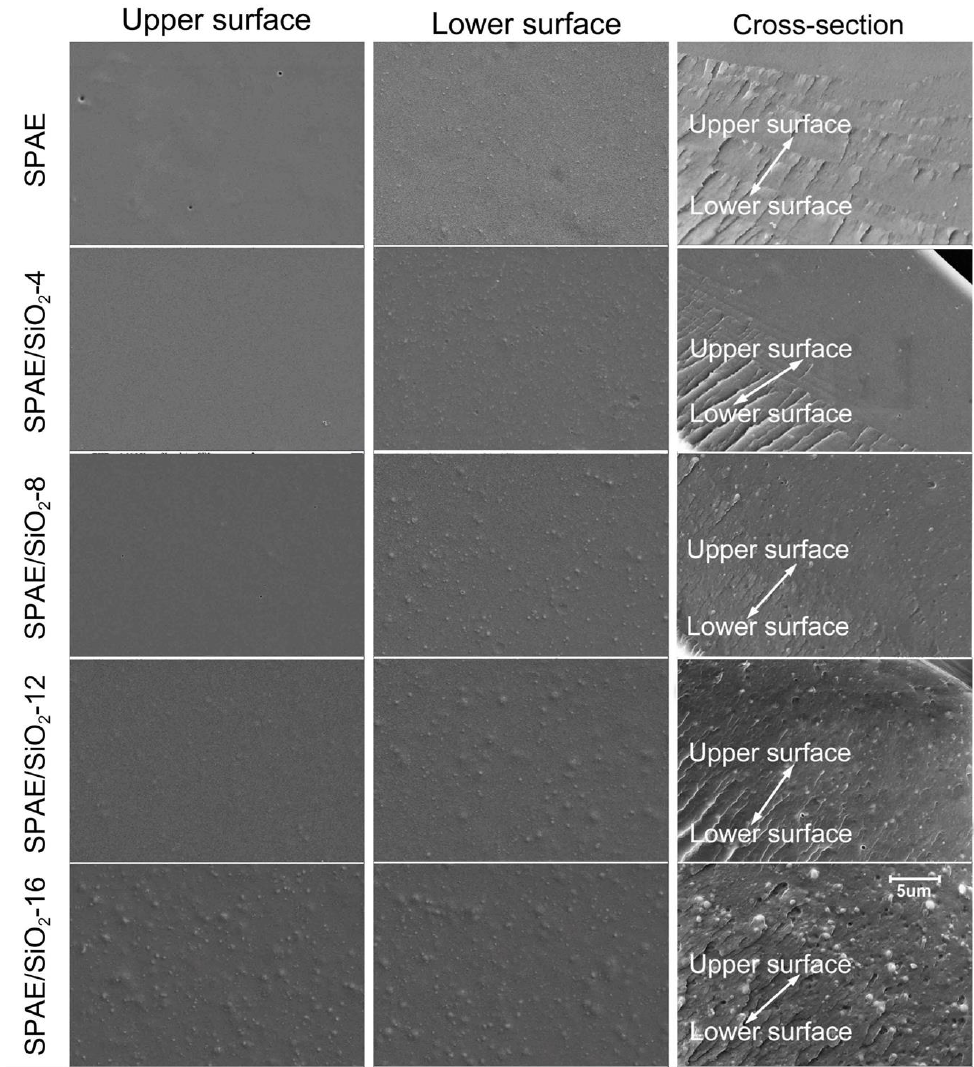
Figure 3. SEM images of the SPAE and SPAE/SiO 2 composite PEMs.